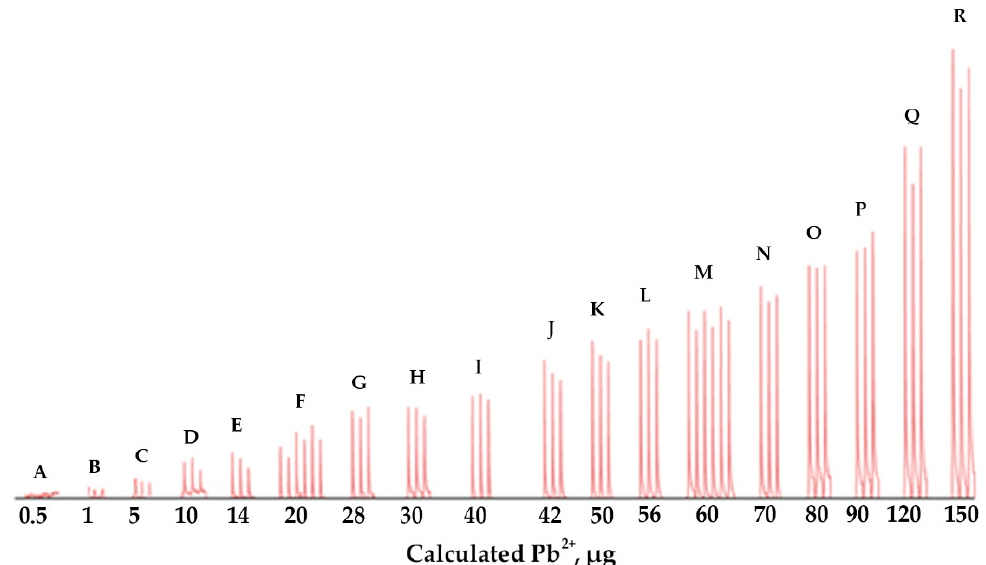
Figure 5. FI responses due to various amounts of Pb 2+ . (See Table 1).